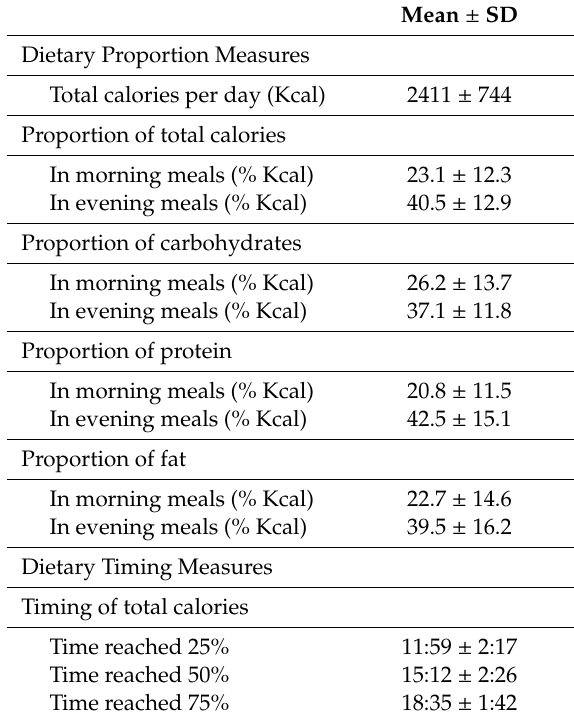
Table 2. Dietary characteristics of study participants ( n =